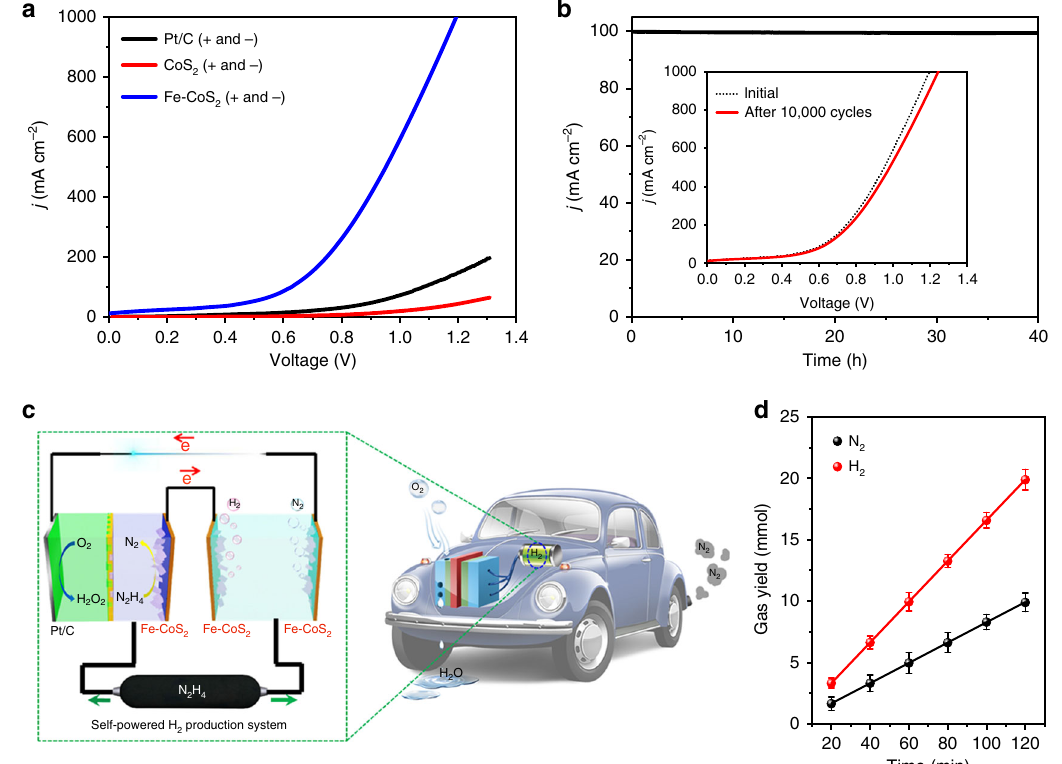
the step between the fi rst two states ( Δ G H* ) for H* on the Co site of the CoS 2 surface and on the Co and the Fe sites of the Fe-CoS 2 surface, and the Δ G H* values were given to be + 0.24 eV (the Co site of CoS 2 ), + 0.15 eV (the Co site of Fe-CoS 2 ) and + 0.35 eV (the Fe site of Fe-CoS 2 ), as displayed in Fig. 5e and Supplementary Fig. 29. The two fi gures also indicate: this step is the potential- determining step (PDS), because only its free-energy change is positive; for Fe-CoS 2 , the H adsorption on the Fe site is less stable than on the Co, and not the Fe site but the Co one is the active site, because + 0.15 eV < + 0.35 eV, which can be ascribed to the lower electronegativity value of Fe (1.83) compared to Co (1.88), leading to a weaker interaction between Fe and positively charged H atoms 38 . + 0.15 eV is also smaller than + 0.24 eV, manifesting that the proceeding of the HER process on the Fe-CoS 2 surface is easier than on the CoS 2 , consistent with the experimental results in Fig. 2a, b. This lower value of + 0.15 eV than + 0.24 eV and thus the HER improvement should be caused by the enhanced charge density of the Co site through the presence of the adjacent Fe atom 39 , which can be veri fi ed with X-ray absorption near edge structure (XANES) measurements. In the obtained XANES spec- tra of Co K-edge (Supplementary Fig. 30), the white-line intensity of Fe-CoS 2 is clearly lower than that of CoS 2 , indicating that the Co cations in Fe-CoS 2 have been partly reduced 40 . That is, the